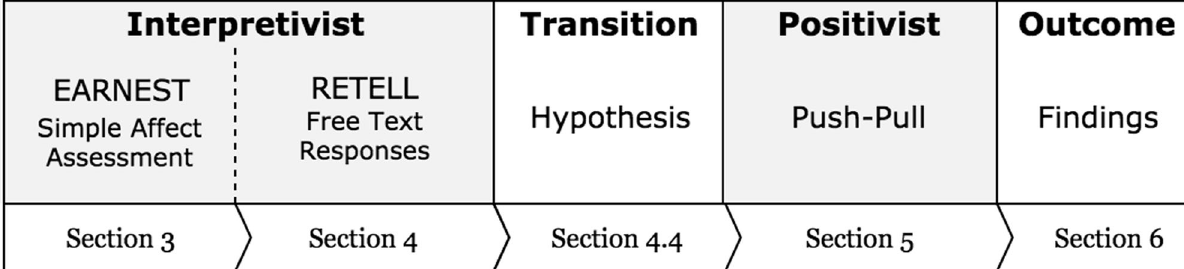
Fig. 2 The paper ’ s research methodology is depicted in this fl ow